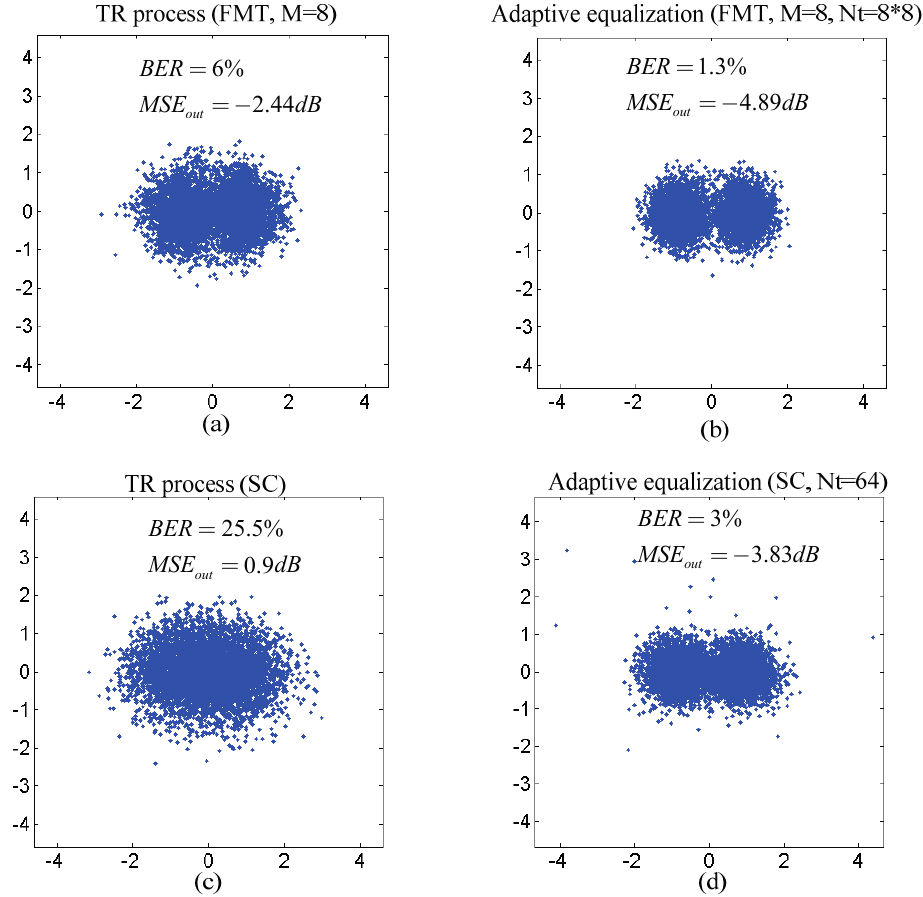
Figure 10. Performance comparison between two communication methods in the experiment: ( a , b ) performance of the TR process and adaptive equalization in the proposed method; and ( c , d ) performance of the TR process and adaptive equalization in the TR acoustic communication using SC